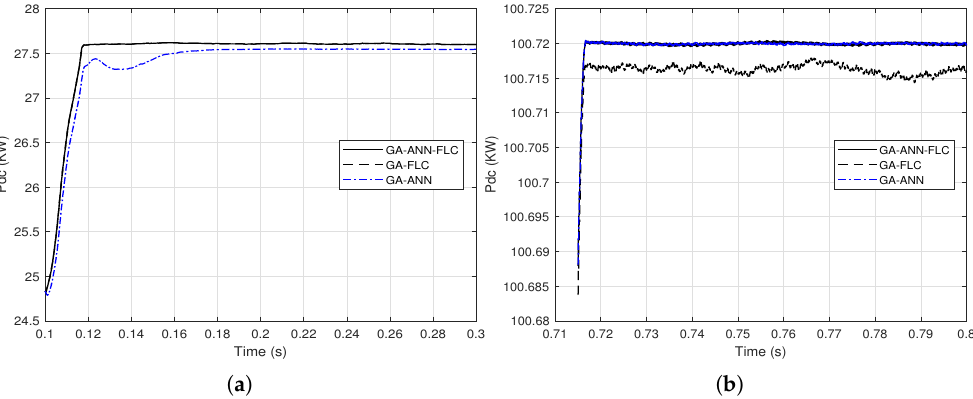
Figure 21. Proximate views of combining the responses of the output DC power from the GA-FLC and the GA-ANN based MPPT methods for the dynamic solar irradiance change ( a ) from 0.1 to 0.3 s; ( b ) from 0.71 to 0.8